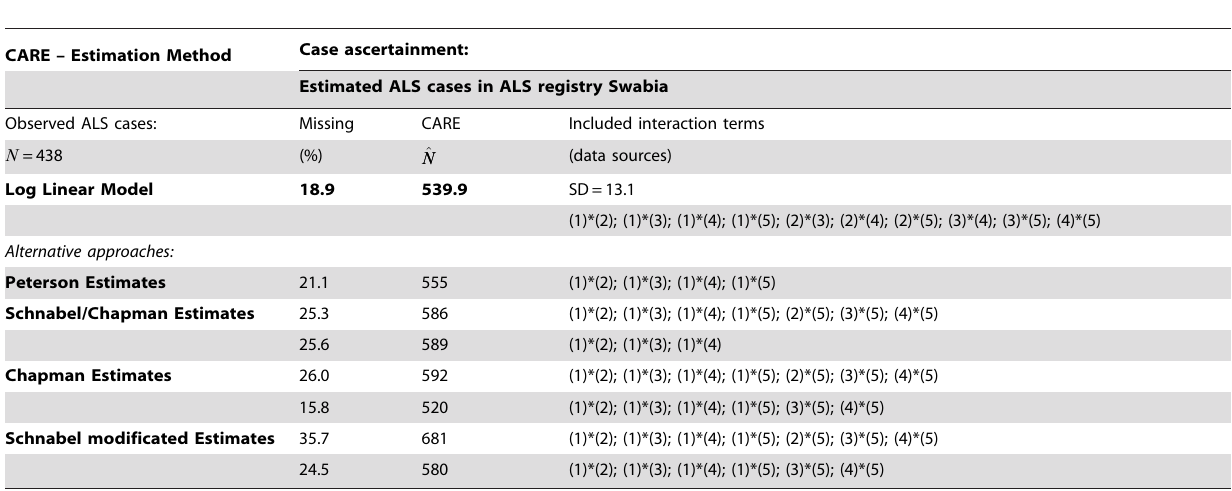
Table 1 . Case ascertainment of the ALS cases in Southern Germany compared by different statistical procedures of capture- recapture methods.